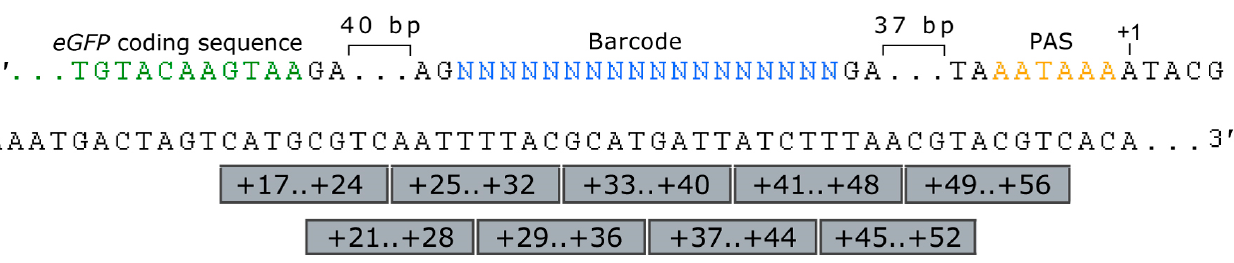
Figure 1. Structure of MPRA libraries (using the example of the sequence of the wildtype reference construct) used to assess an influence of sequences located downstream of the PAS on the eGFP reporter gene expression. PAS—polyadenylation signal (AATAAA). ROIs are shown as gray boxes. The nucleotide sequence of the 3 ′ end of the eGFP coding sequence is shown in green. Here, “40 bp” and “37 bp” designate spacers, whose nucleotide sequences are not shown for simplicity reason.